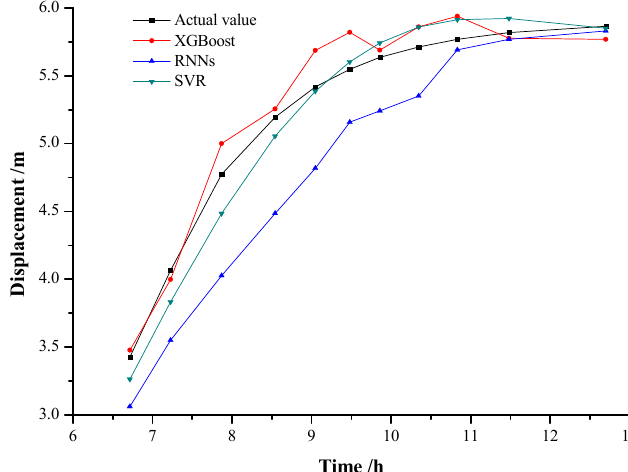
Figure 9. Variation of displacement predicted values of D8 with time.